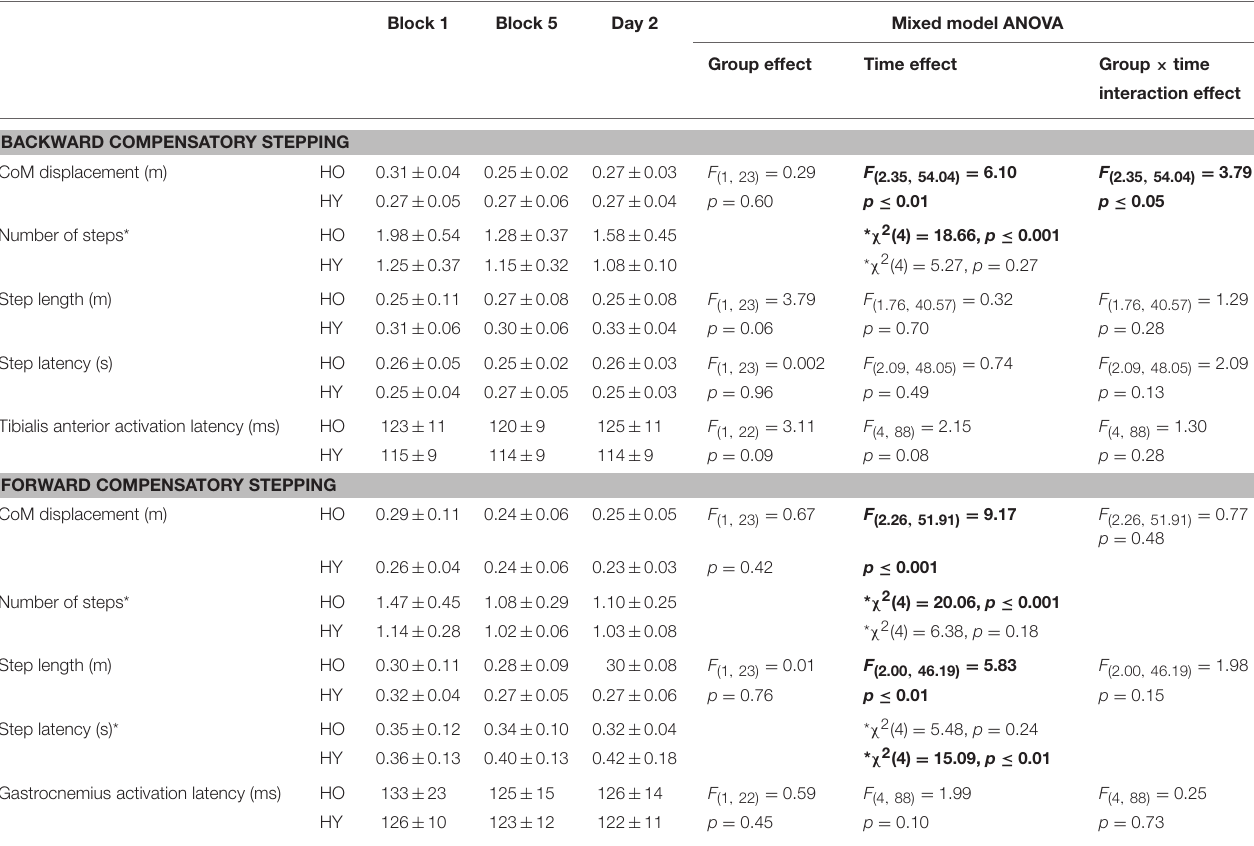
TABLE 3 | Adaptations during the motor training (represented as mean ±